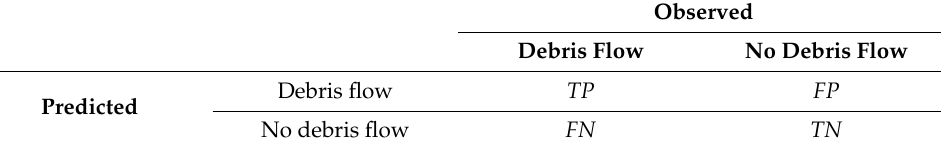
Observed Debris Flow